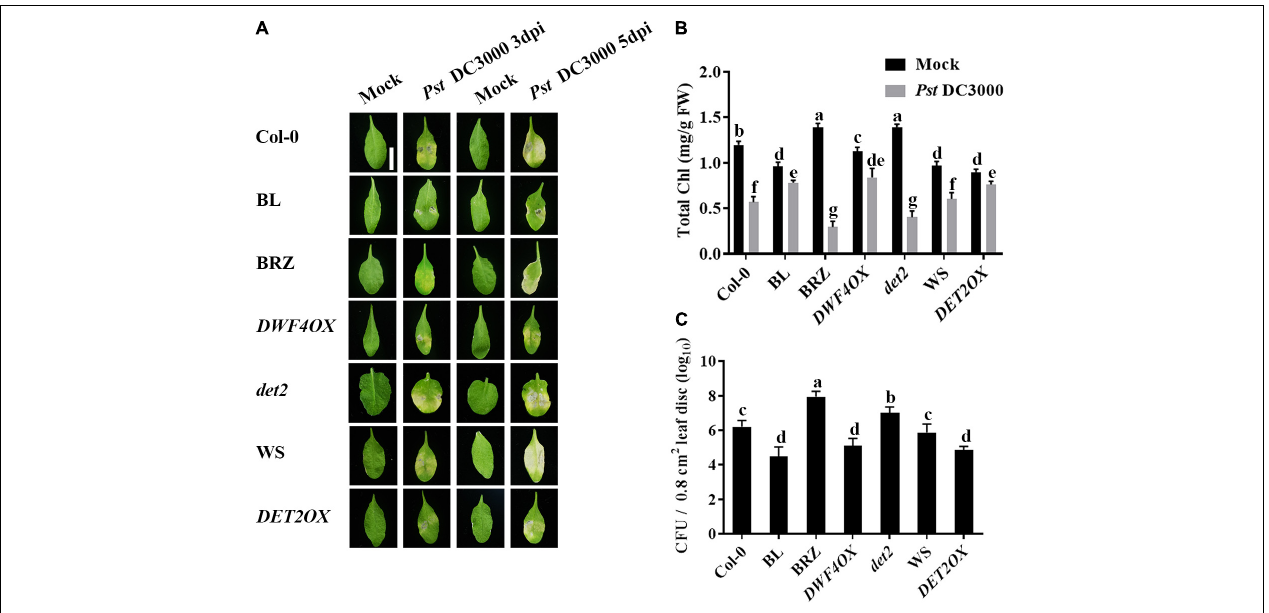
FIGURE 1 | Brassinosteroids (BRs) increase resistance to Pst DC3000. (A) Typical Pst DC3000 infection symptoms in Col-0, BL-treated, BRZ-treated, DWFOX , DET2OX , WS, and det2 plants. Pictures were taken at 3 and 5 dpi, respectively. Bar, 1.00 cm. (B) Total chlorophyll content in inoculated leaves was detected in planta at 3 dpi. (C) Bacterial growth in the inoculated leaves was detected in planta. Bacteria were isolated from plants at 1 dpi and quantified with gradient dilution assays. Bars represent mean ± SD obtained from three biological replicates per genotype and time point, chlorophyll content or bacterial growth measured from five leaves of each genotype and treatment were pooled for one replicate. Significant differences ( P < 0.05) are denoted by different lowercase letters.